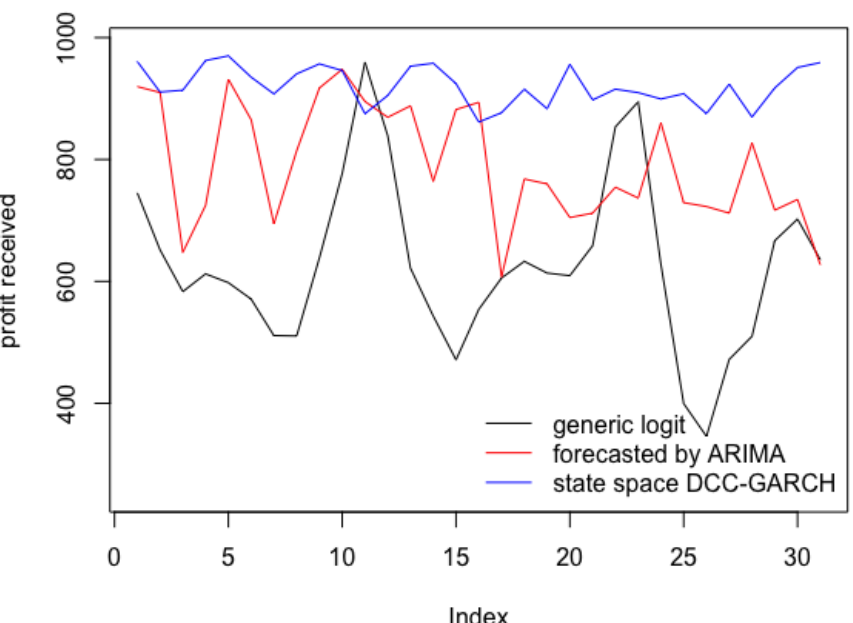
Figure 7. Amount of received profit for tested methods by time period.